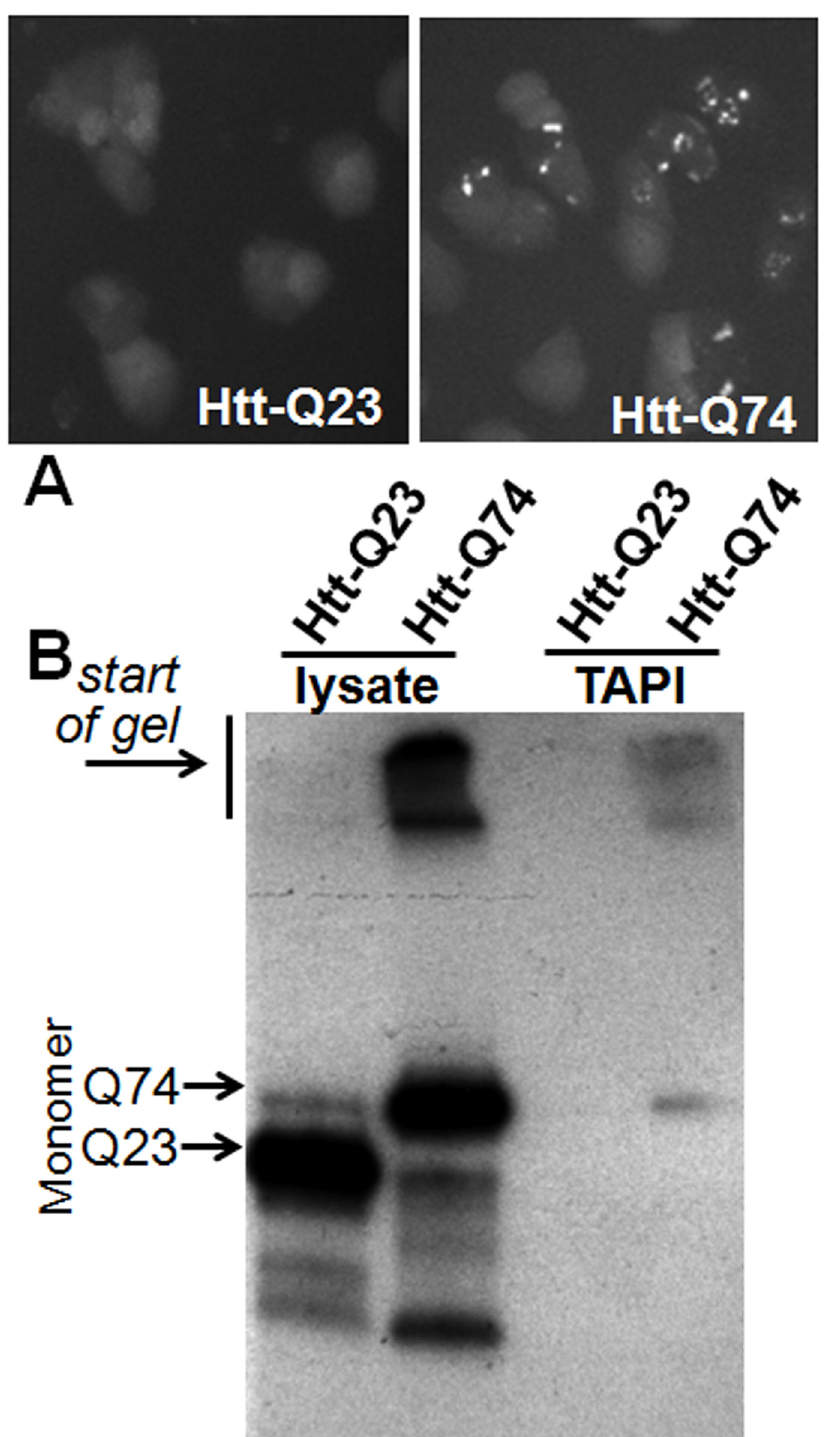
Fig 4. Polyglutamine-expanded Huntingtin exon 1 forms aggregates in PC-12 cells that can be isolated by TAPI. (A) Fluorescence microscopy of PC-12 cells expressing doxycycline inducible transgene GFP-tagged Huntingtin exon 1 (Htt) with normal (Q23) or expanded polygluamine tract (Q74). (B) Western blot of GFP-Htt-Q23 and GFP-Htt-Q74 showing high molecular weight aggregates can be isolated from Htt- Q74 expressing PC-12 cells. Lysate = input; TAPI = purified aggregates.